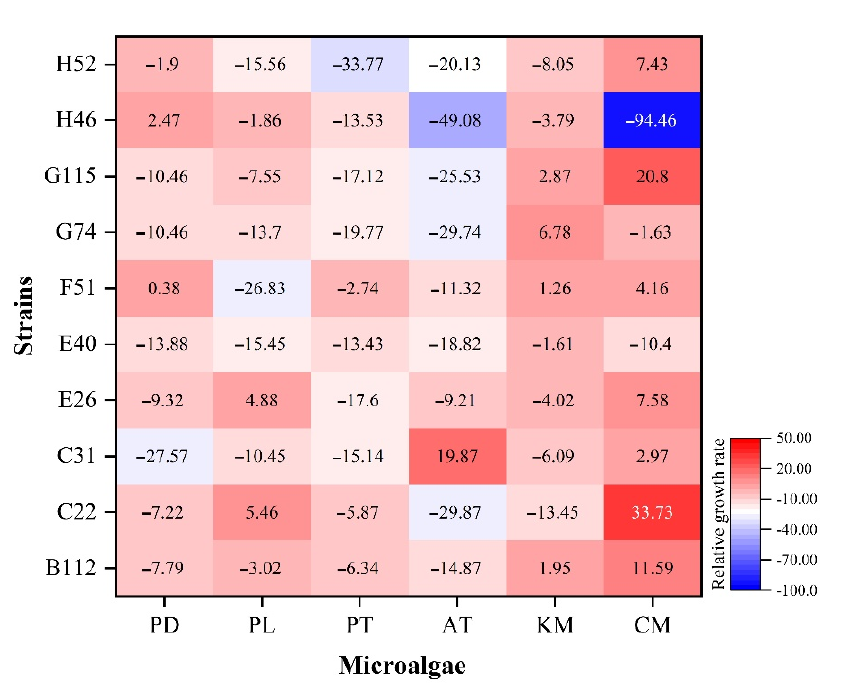
Figure 6. The effect of QS bacterial metabolites on the growth of microalgae.